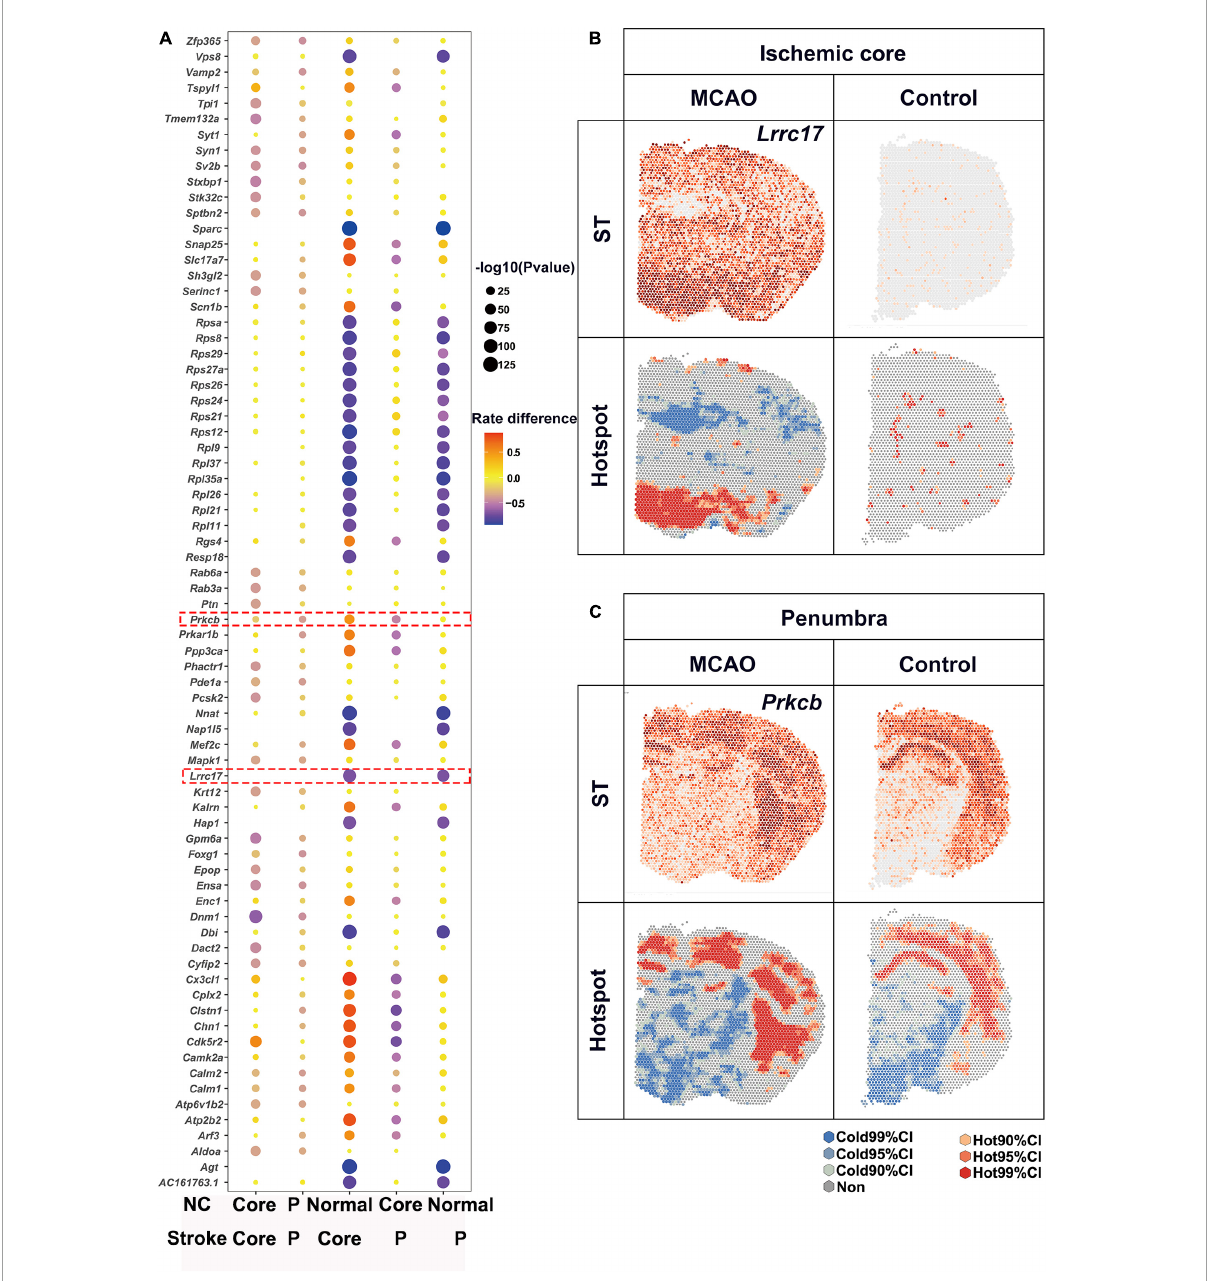
FIGURE5 Downregulated DEGs revealed by saSpatial. (A) Bubble plots of top20 DEGs. P -values are indicated by circle size; scale adjacent to the plot. The rate difference are indicated by color. NC, normal control. P, penumbra. Typical DEGs of (B) ischemic core and (C) penumbra. N = 3. ST, spatial transcriptomic; CI, confidence